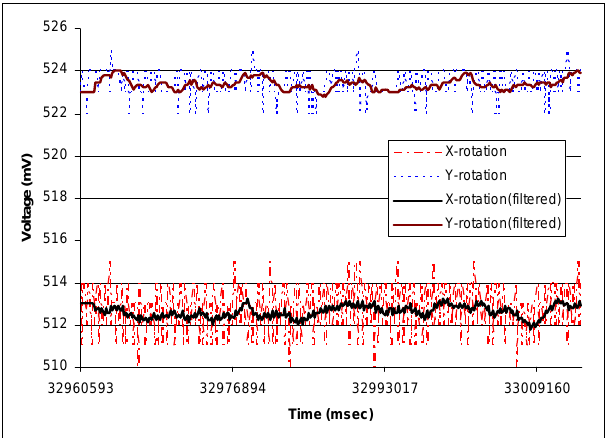
Figure 10. X- and Y-axis readings when the accelerometer is stationary with and without the smoothing filter.